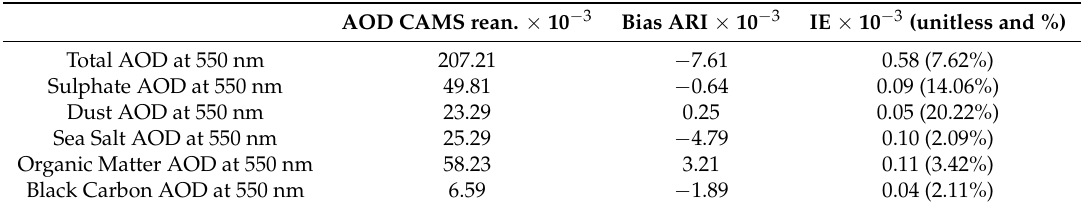
Table 2. Mean values of Aerosol Optical Depth at 550 nm (unitless) for the CAMS reanalysis in the domain; bias of the simulation for the base case (ARI) and improvement of the error with respect to the base case simulation when including ACI. A positive value of the improvement indicates a reduction of the error in the ACI simulation with respect to the base